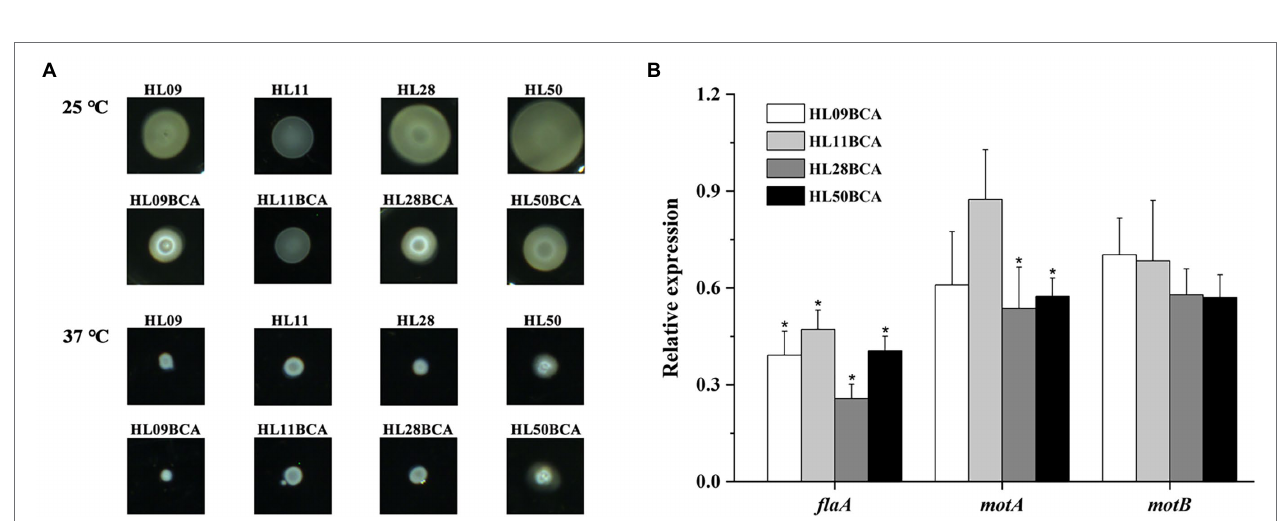
FIGURE 5 | (A) Biofilm biomass of HL28, HL28BCA, HL28 Δ luxS , HL28 Δ luxS BCA, HL28 Δ agr and HL28 Δ agr BCA at 37 ° C for 48 h. (B) Surviving planktonic cells in the bacterial culture incubated at 37 ° C for 48 h. Error bars represent the standard deviation of triplicate experiments ( n = 3). The asterisk indicates a value statistically different from that of the wild-type strain, with p < 0.05.